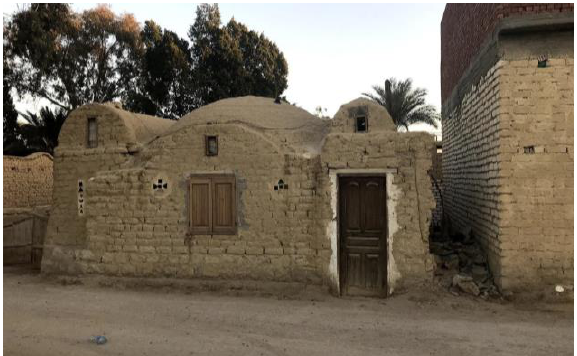
Figure 17. The old mud brick house of Ahmed Abdallah stands next to the new concrete building of his extended family’s house, 1990 © Author picture, 2019.